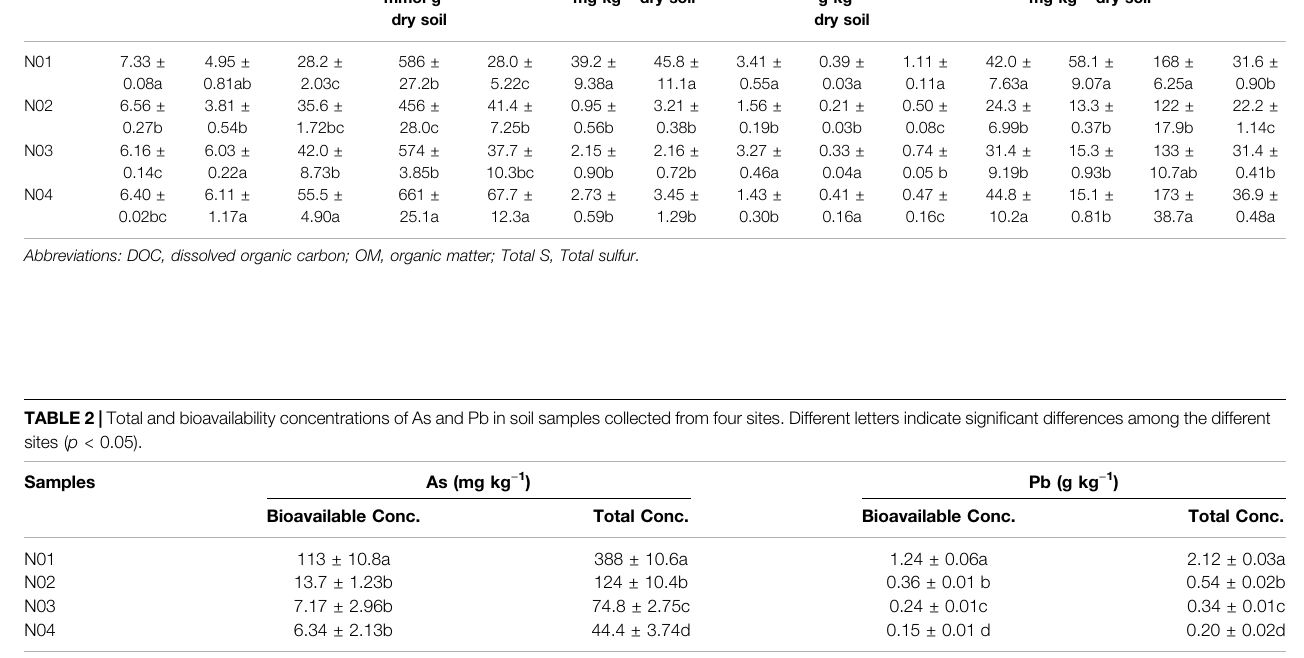
TABLE 1 | Physicochemical characteristics of the paddy soil samples from each site. Different letters indicate signi fi cant differences among the different sites ( p < 0.05). Samples